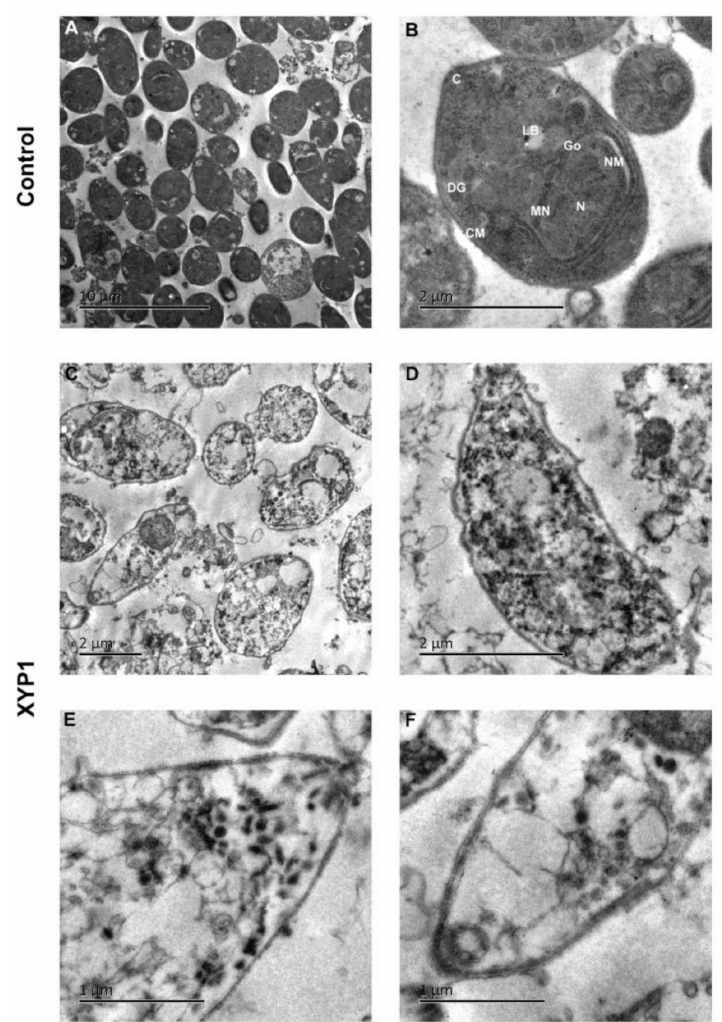
Figure 6. Ultrastructural effects of XYP1 on T. gondii tachyzoites as visualized by TEM. Para- sites treated with DMEM were defined as the negative control ( A , B ). Tachyzoites were exposed to 10 µ M XYP1 for 2 h ( C – F ). Abbreviations in B: C, conoid; CM, cell membrane; DG, dense granule; Go, golgi complex; LB, lipid body; MN, microneme; N, nucleus; NM, nuclear membrane. Scale bars = 10 µ m ( A ); 2 µ m ( B – D ); 1 µ m ( E , F